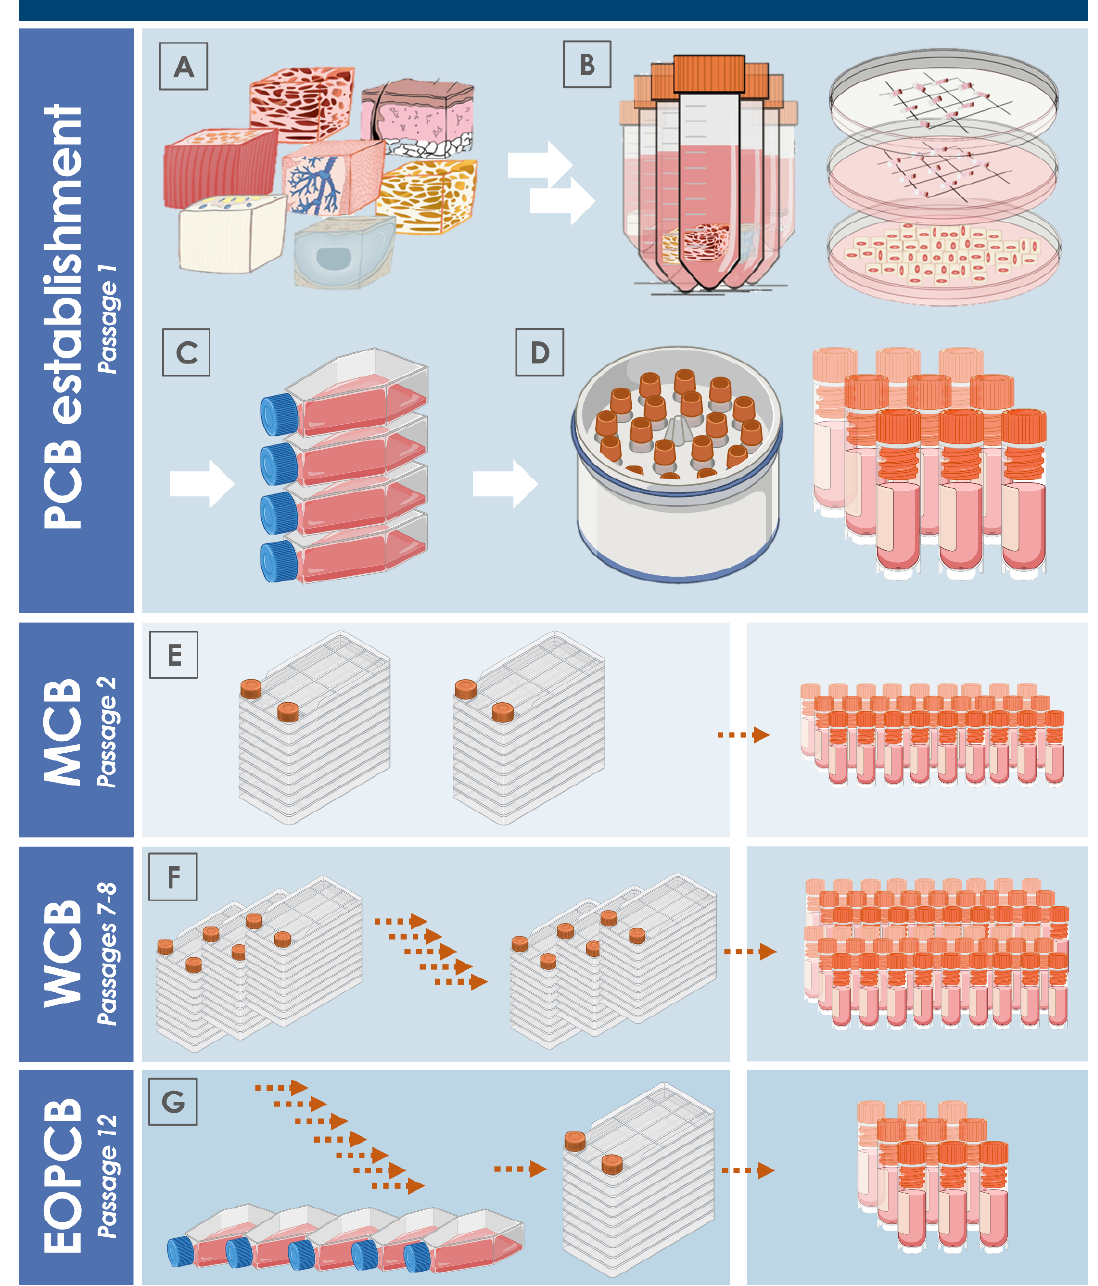
Figure 7. Schematic overview of the technical steps to be undertaken for primary diploid cell type establishment and serial culture expansion for multi-tiered cell bank establishment. ( A ) Procurement of specific starting biological materials. ( B ) Enzymatic or mechanical cell dissociation. ( C ) Preliminary expansion in cell culture vessels. ( D ) Cryopreservation and constitution of a parental cell bank. ( E ) Manufacture of master cell banks. ( F ) Manufacture of working cell banks. ( G ) Manufacture of an end of production cell bank. Exhaustive documentation of the successive steps and thorough characterization, qualification, and release testing schemes allow for the safe and sustainable use of considered diploid cell sources. EOPCB, end of production cell bank; MCB, master cell bank; PCB, parental cell bank; WCB, working cell bank.